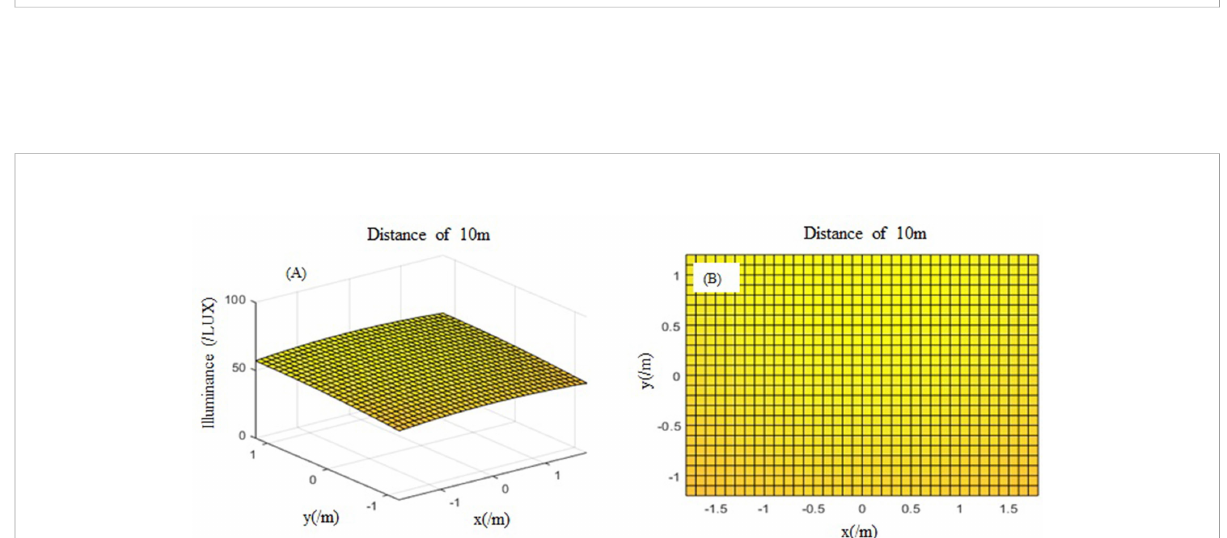
FIGURE 9 The illumination distribution analysis of whole-lighting system with a lighting distance of 10m. (A) the 3D view of illumination distribution; (B) the vertical view of illumination distribution.